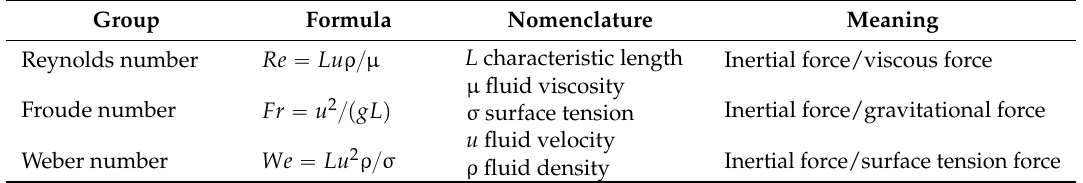
Table 1. Dimensionless groups.